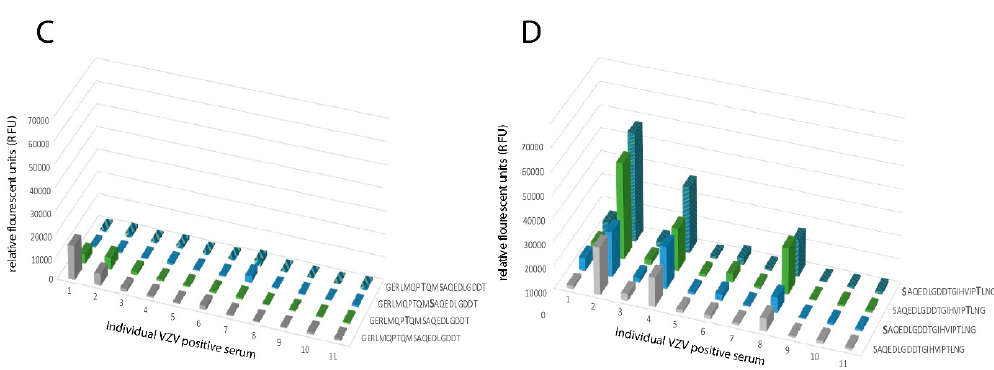
Figure 5. A homogenous response towards synthetic peptides with single or multiple GalNAc modifications was observed for peptides covering parts of the N-terminal region of gE. ( A ) Synthetic peptide 64-WVNRGESSRKAYDHNSPY-81 unmodified or modified by GalNAc residues at either Ser or Tyr, or a combination of both. ( B ) Synthetic peptide 73-KAYDHNSPYIWPRNDYDG-90 unmodified or modified by GalNAc residues at either Ser or Tyr. ( C ) Synthetic peptide